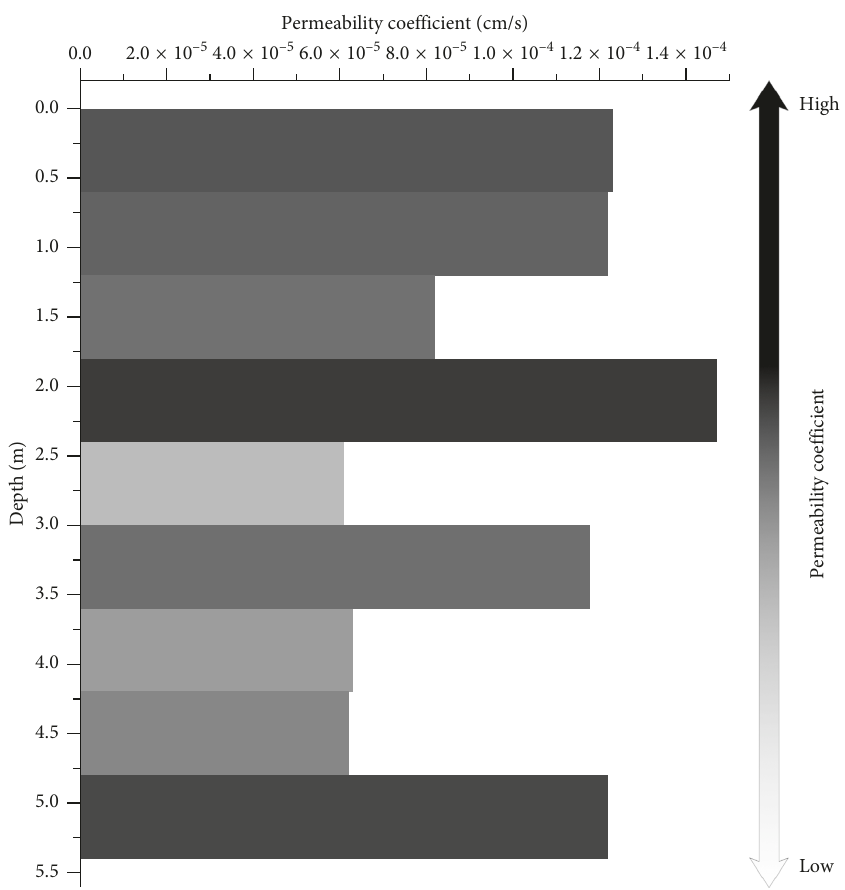
Figure 7: Vertical step diagram and gradient diagram of permeability coefficient. The gray scale indicates the permeability of loess in this layer. The darker the color, the faster the water can pass through the